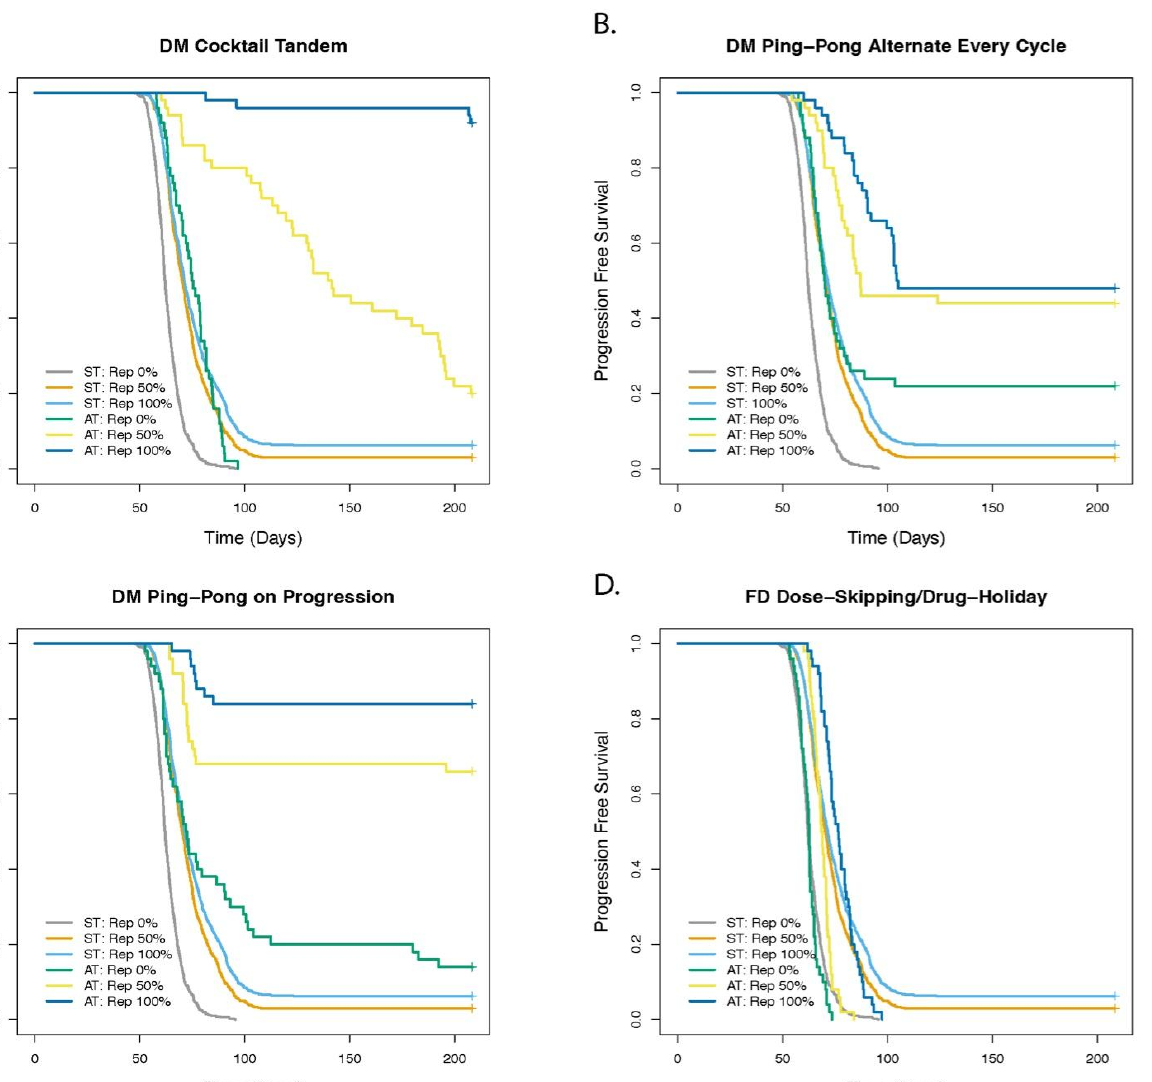
Figure 7. Effect of replacement on outcome of adaptive therapy with 2 drugs. The panels show the comparison of adaptive therapy (AT) versus standard treatment (ST) as the replacement parameter is varied for A. DM Cocktail Tandem, B. DM Ping-Pong Alternate Every Cycle, C. DM Ping-Pong